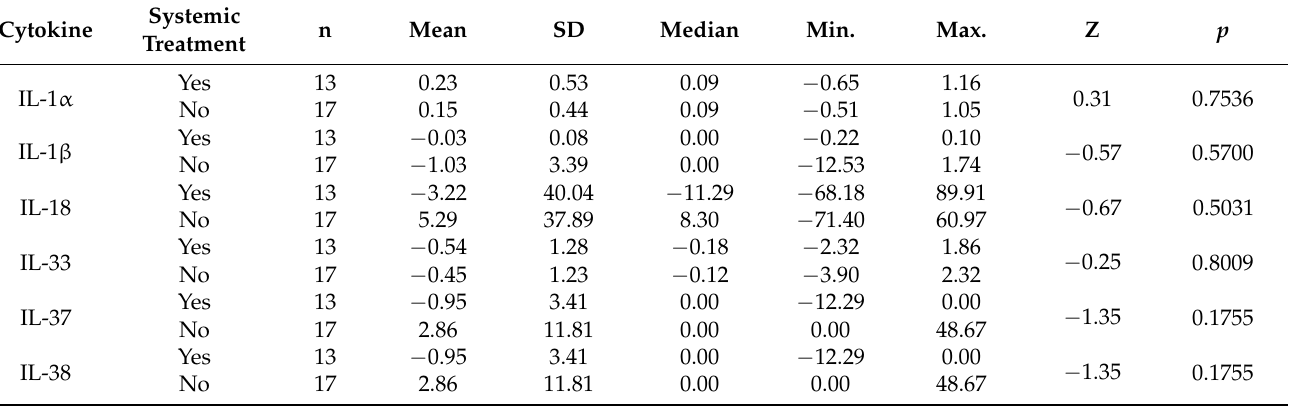
Table 7. Comparison of changes in cytokines concentrations in LoS patients depending on receiving systemic